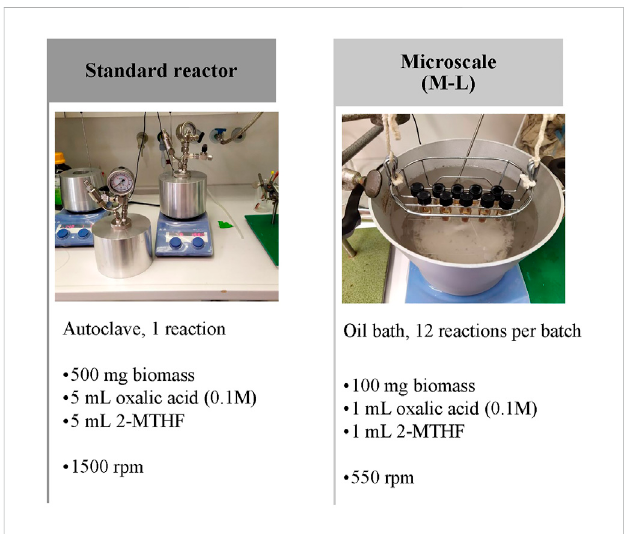
FIGURE 1 OrganoCat standard reactor system and and small systems